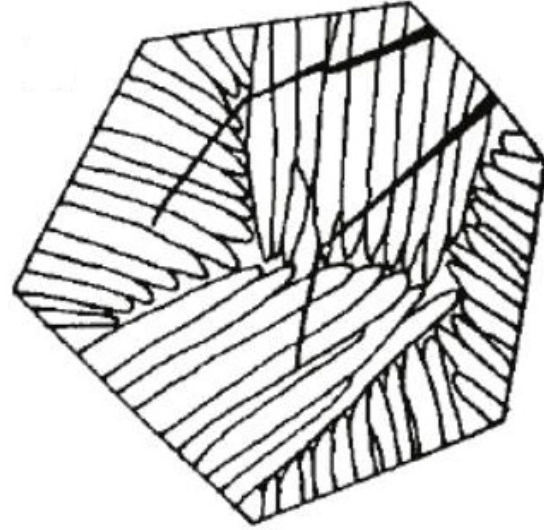
Figure 11. Crack propagation path in acicular ferrite. Microstructure is the main factor affecting the strength and hardness of the joint. In welding thermal cycle, the joint is completely austenitized because of rapid heating to peak temperature, and then cooled to room temperature at different cooling rates, causing different types of phase transition. Carbon supersaturation in structure directly